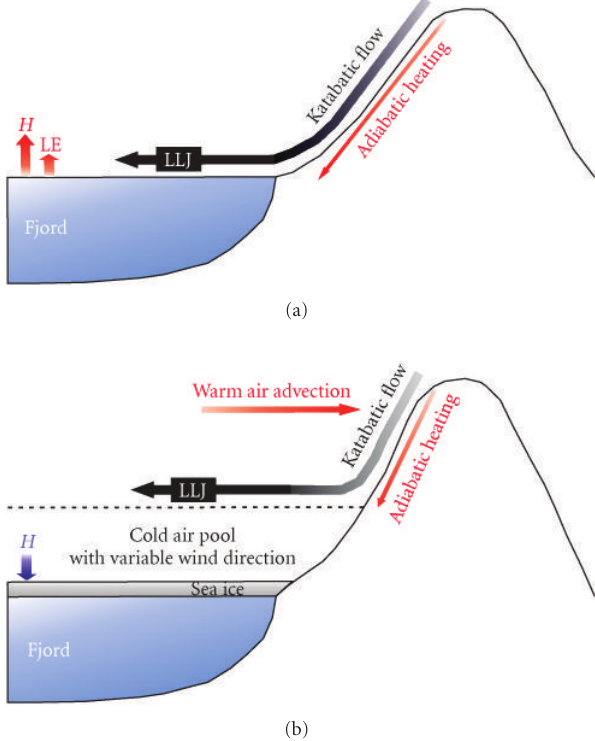
Table 5: Statistics of low-level jet parameters.